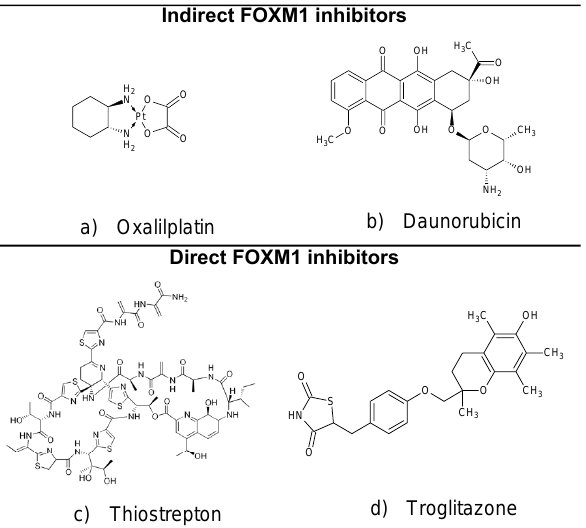
Figure 2. Previously reported indirect and direct FOXM1 inhibitors. Indirect FOXM1 inhibitors: ( a ) oxalilplatin and ( b ) daunorubicin. Direct FOXM1 inhibitors: ( c ) thiostrepton and ( d ) troglitazone.